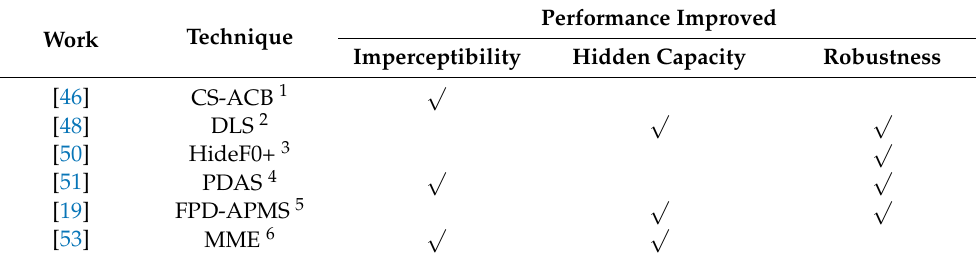
Table 6. Steganography methods based on ACB.